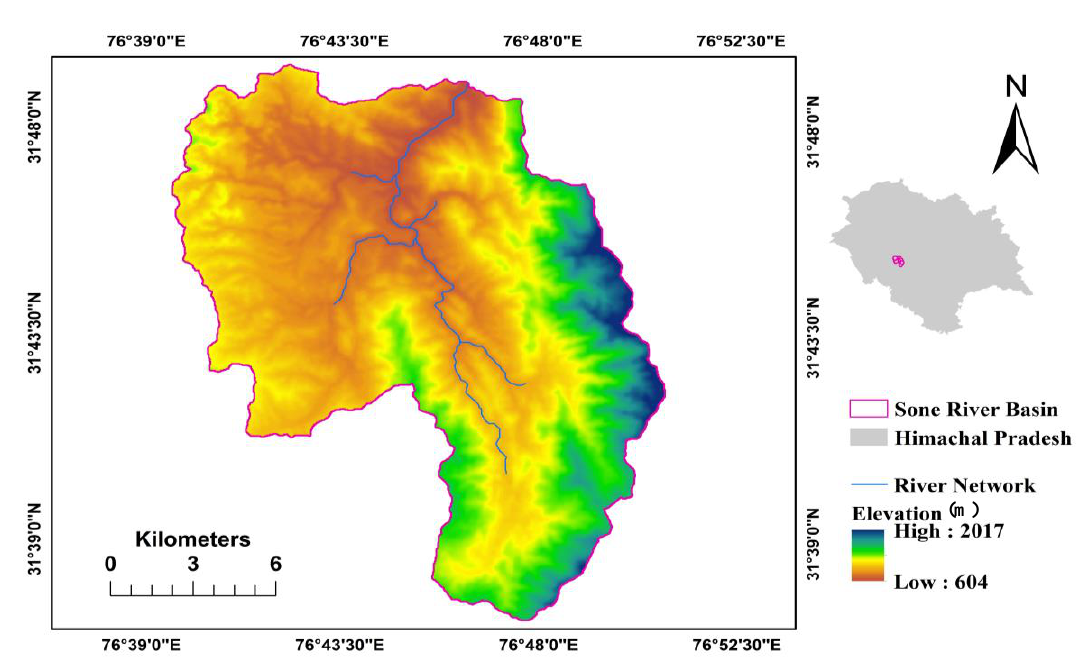
Figure 1. Study Area: Sone River Basin and River Network